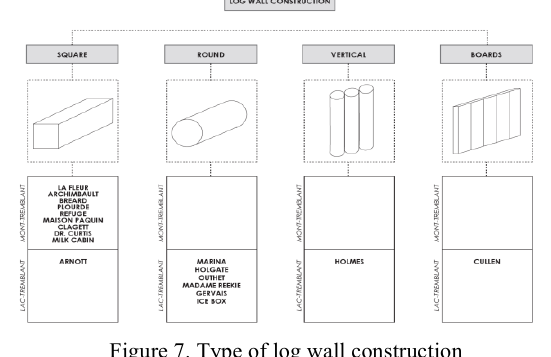
Figure 7. Type of log wall construction